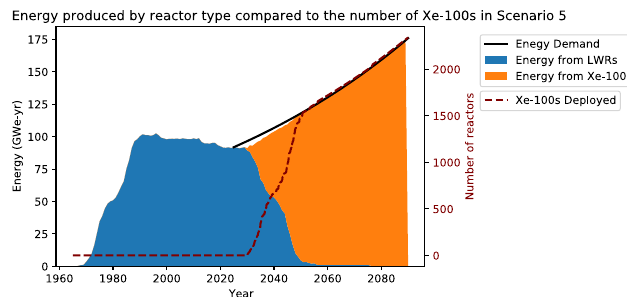
Fig. 14. Energy supplied by each type of reactor compared to the number of Xe-100s deployed in Scenario